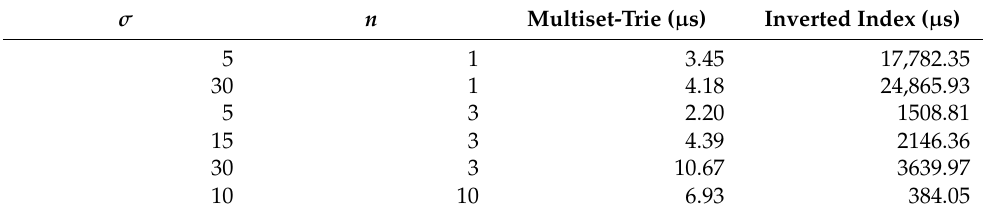
Table 2. Exact search.